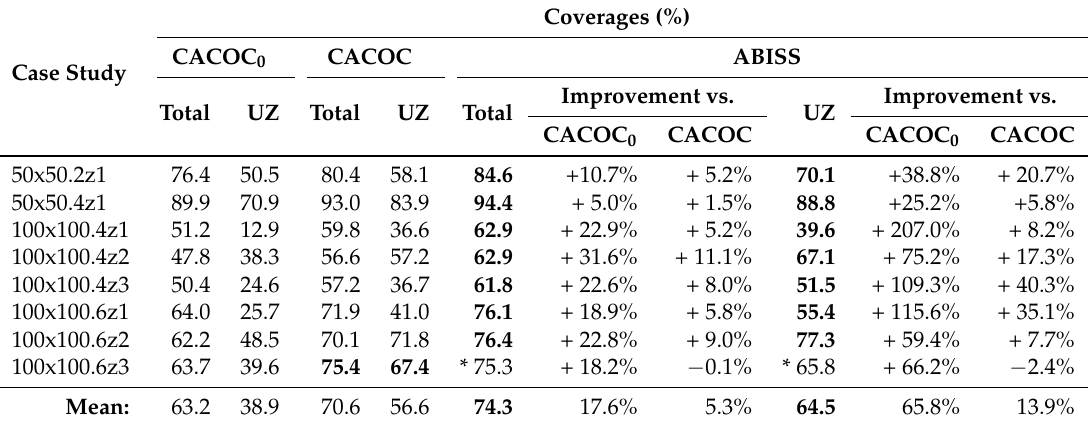
Table 7. Comparison between the coverage values obtained by the non-collaborative approaches (CACOC 0 and CACOC) and ABISS in case studies having unreachable zones (mean of 30 scenarios). The improvements achieved by ABISS with respect to CACOC 0 and CACOC are also reported. The second best configuration values are indicated by asterisks. The best results are in